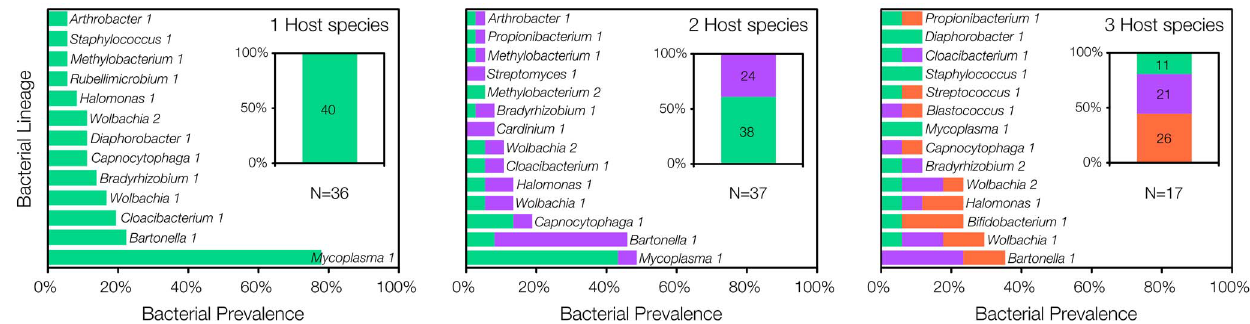
Figure 3. Bacterial prevalence in G erbillusandersoni (green), G.pyramidum (purple), and G.gerbillus (red) as a function of host species richness. Lineages found in at least two host individuals are shown in the main figures, and unique lineages are included in the right-hand inserts. Numbers in the right-hand inserts indicate the total number of unique lineages observed for each host species.